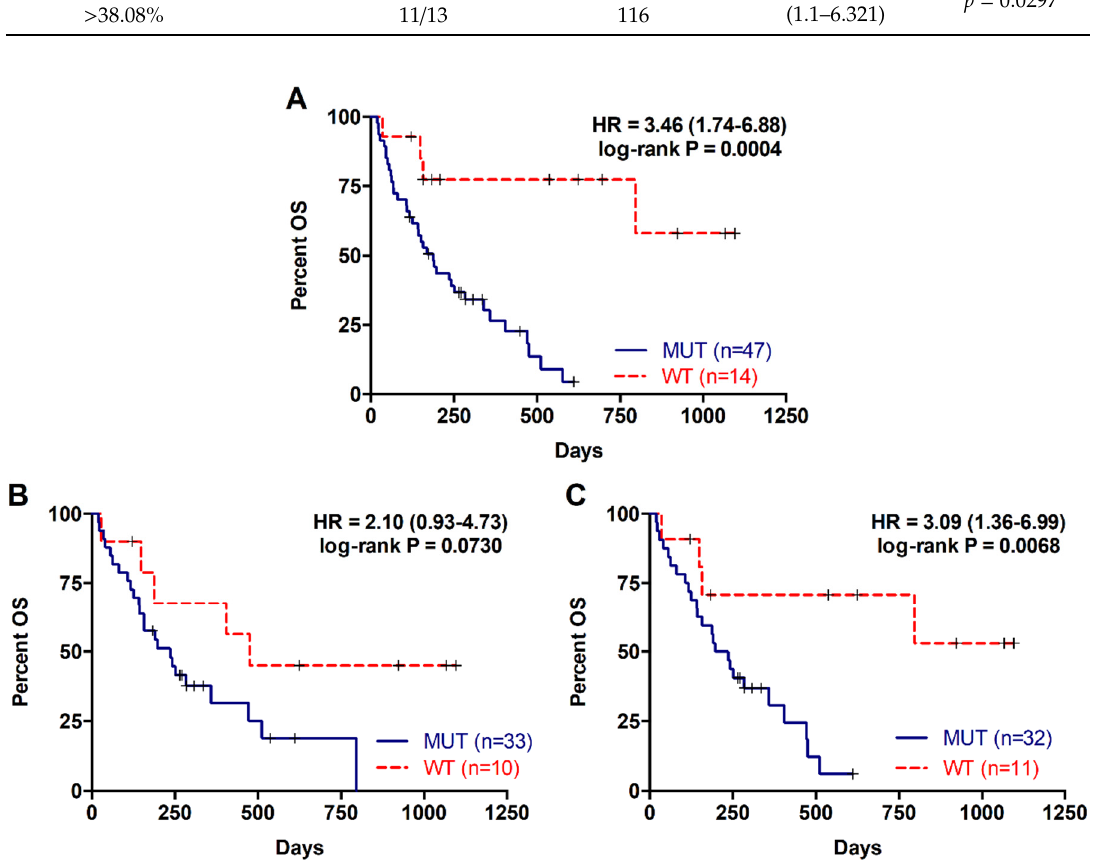
Figure 1. Overall survival rates for patients with metastatic PDAC according to RAS mutation status. ( A ) OS according to RAS mutation status in cfDNA; ( B ) OS according to RAS mutation status in tissue; ( C ) OS according to RAS mutation status in cfDNA of those patients with RAS mutations analyzed in tissue. Table 3. Progression-free survival analysis.